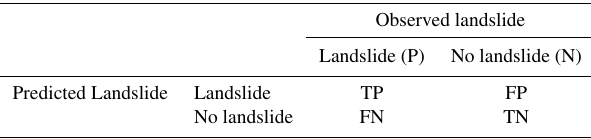
Table 1. Confusion matrix for ROC